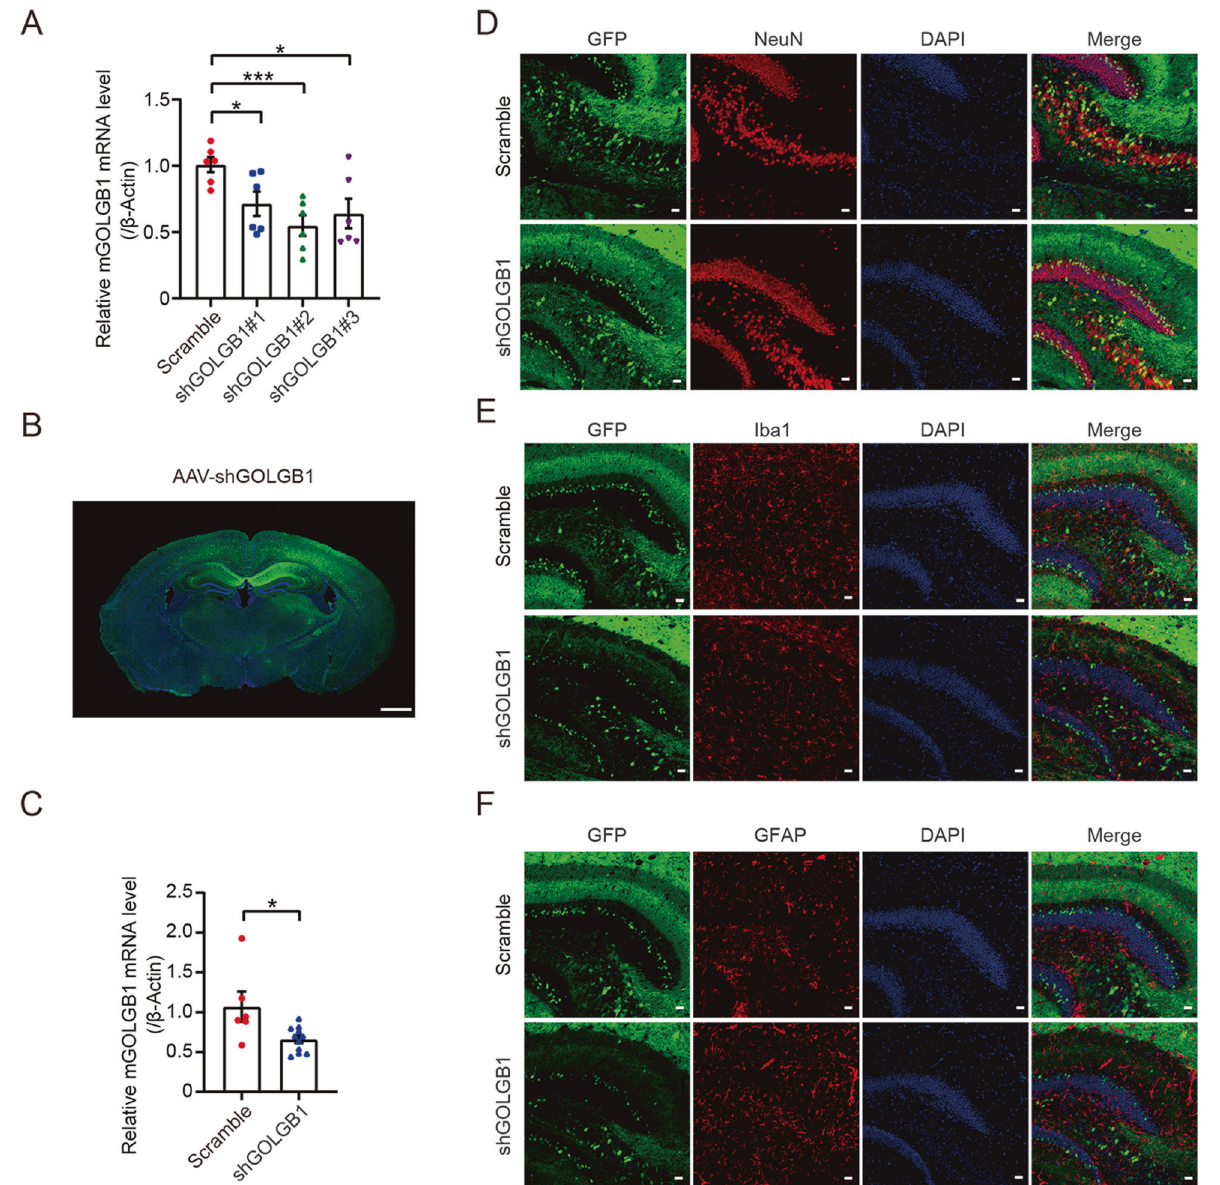
Fig. 2 Downregulation ef fi ciency and expression localization of AAV-GOLGB1 shRNAs. A Mouse primary neurons were infected with AAVs expressing different mouse Golgb1 shRNAs (shGOLBG1 #1, #2, and #3) or a scrambled control shRNA. The mRNA levels of mouse Golgb1 were determined by qRT-PCR and normalized to those of β -actin for comparison. n = 6; * p < 0.05, *** p < 0.001; two-tailed Student ’ s t -test. B Representative image of the GFP expression (in green) in mice injected with AAVs. The nuclei were counterstained with DAPI (in blue). Scale bar: 1 mm. C RNAs were extracted from hippocampal tissues of mice injected with AAVs expressing shGOLGB1 or a scrambled control shRNA. The mRNA levels of mouse Golgb1 were determined by qRT-PCR and normalized to those of β -actin for comparison. n = 11 for shGOLGB1 mice, n = 6 for scrambled control mice; * p < 0.05; two-tailed Student ’ s t -test. D – F The brain of mice injected with GFP (in green)-containing AAVs expressing shGOLGB1 or a scrambled control shRNA were sectioned. Brain sections were immunostained with the neuron marker NeuN ( D , in red), the microglia marker Iba1 ( E , in red), and the astrocyte marker GFAP ( F , in red), and counterstained with DAPI (in blue). Scale bars: 30 μ m. The hippocampal regions were observed under a confocal microscope. that Golgb1 KD mice were more active than control mice, as they found to colocalize with the neuron marker NeuN (Fig. 2D) but not exhibited signi fi cantly increased total travel distance and numbers with the microglia marker Iba1 (Fig. 2E) or the astrocyte marker of center entries (Fig. 3A). In the tail suspension test, we found that GFAP (Fig. 2F), suggesting that AAVs mostly infected neurons, i.e., Golgb1 KD mice had less immobility time than control mice Golgb1 was mostly downregulated in neurons. (Fig. 3B), implying a decrease of depression in Golgb1 KD mice. We next investigated whether Golgb1 knockdown (KD) affects Consistently, Golgb1 KD mice had increased sucrose preference mouse behaviors. Two months after AAV infection, both male and indicative of decreased depression compared control mice in the female mice were subjected to various behavioral tests. Since both two-bottle choice sucrose preference test (Fig. 3C). Surprisingly, in sexes are affected in this BD family, we combined data from mice the forced swim test, Golgb1 KD mice showed signi fi cantly with both sexes for comparisons. In the open fi eld test, we found